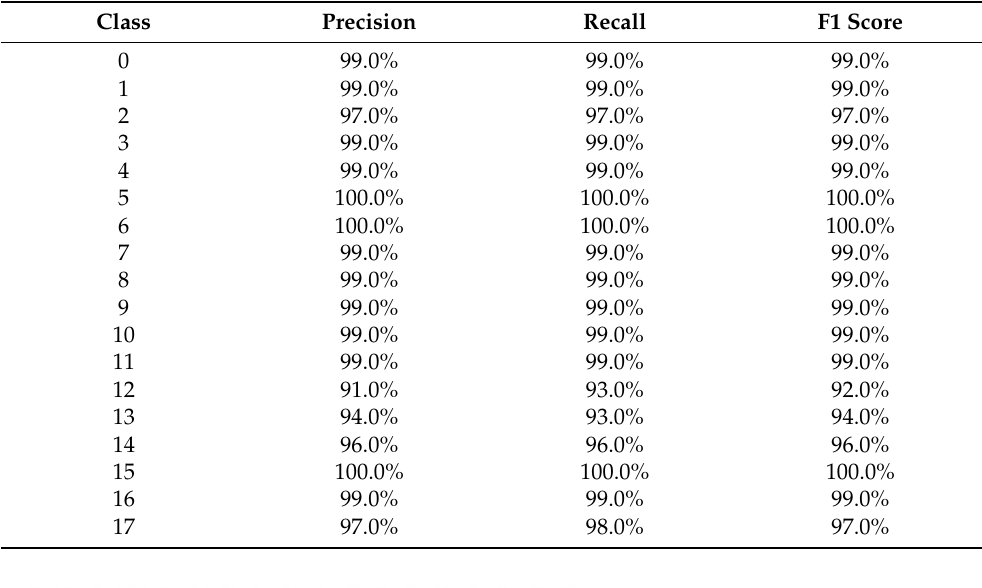
Table 3. Performance evaluation of expanded data.